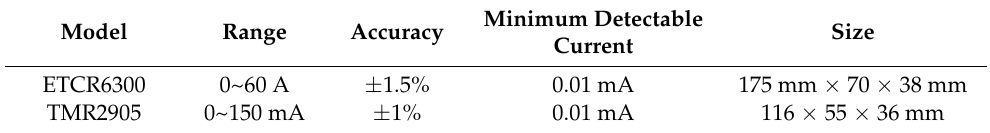
Table 5. Parameters of the current clamp meter.